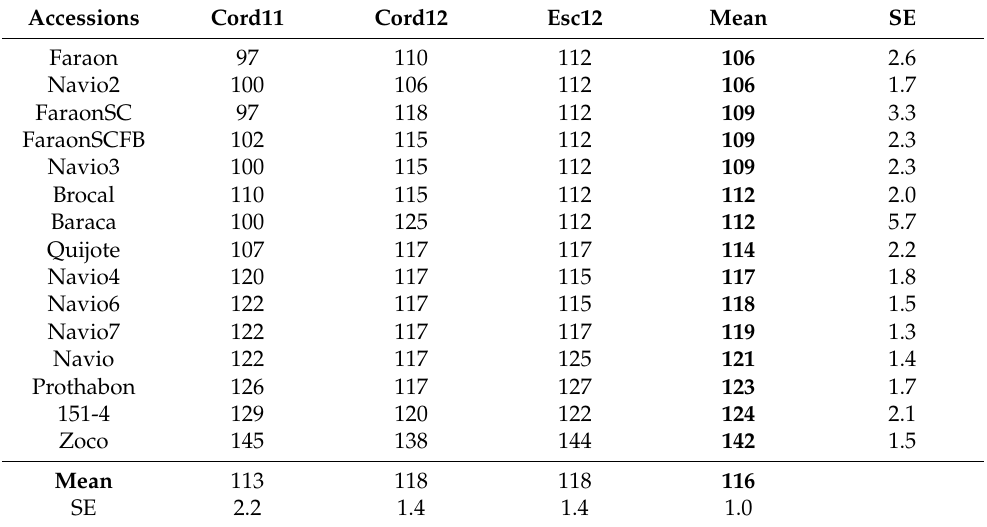
Table 7. Mean days to flowering of 15 faba bean accessions tested at three location–year environments.